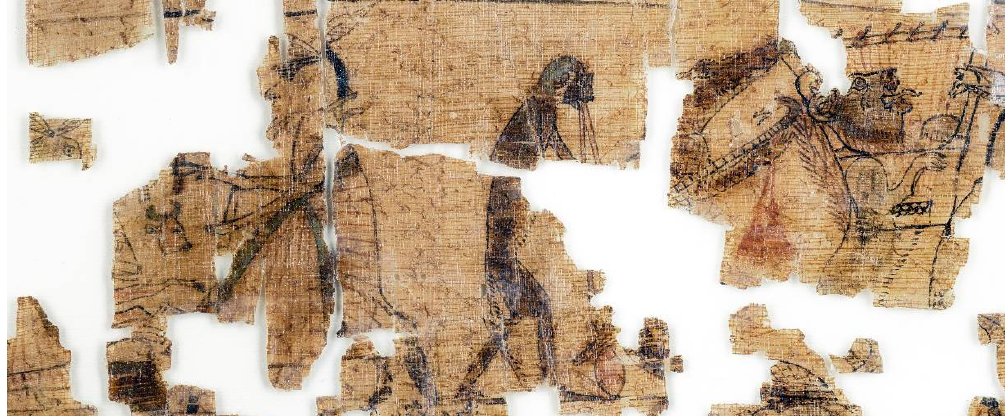
Figure 14. Donkey standing before offerings (left) and a musical ensemble (detail of CME inv. no. c.2031, CGT no. 55001), papyrus, Deir el-Medina, 20th Dynasty (Image courtesy of the Egyptian Museum, Turin).